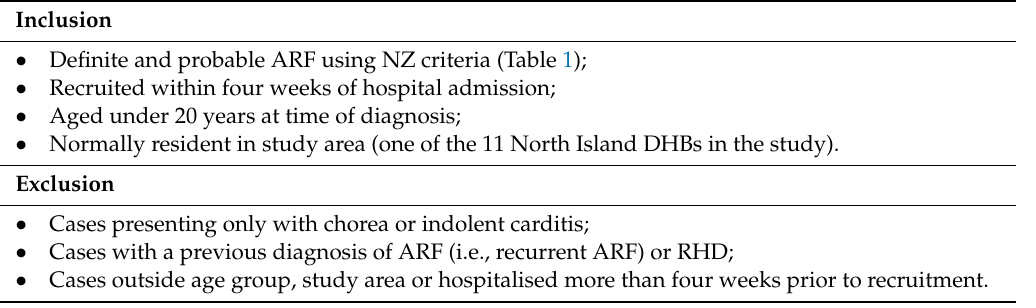
Table 2. Inclusion / exclusion criteria for ARF RISK